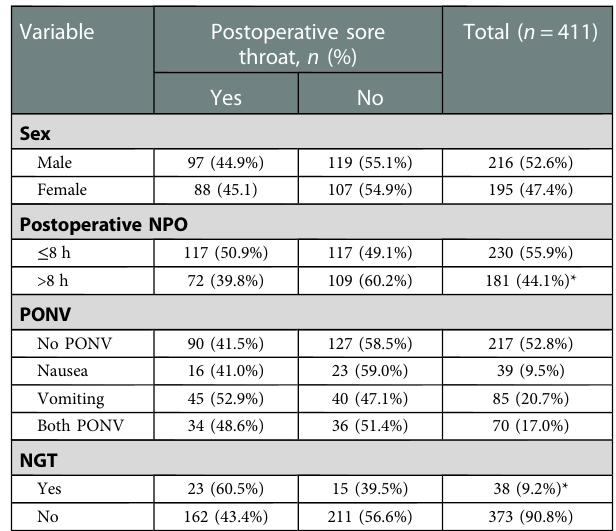
TABLE 1 Patients sociodemographic and surgery-related characteristics of pediatric patients at Northwest Amhara Referral Hospitals, from March 1 to June 30, 2022 ( N